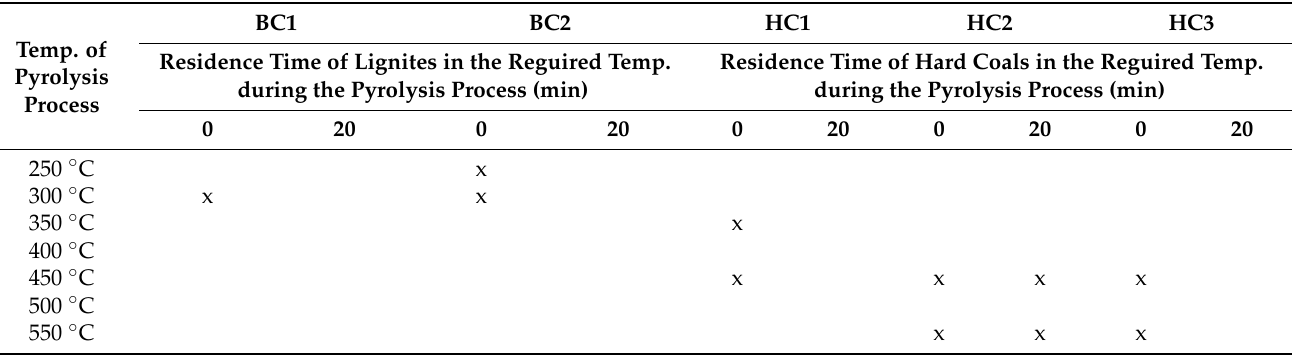
Table 4. Experimental temperature ranges for testing and residence time impact on Hg content removal from lignite (BC1, BC2) and hard coals (HC1, HC2, HC3). The experiment scale was 100 g.